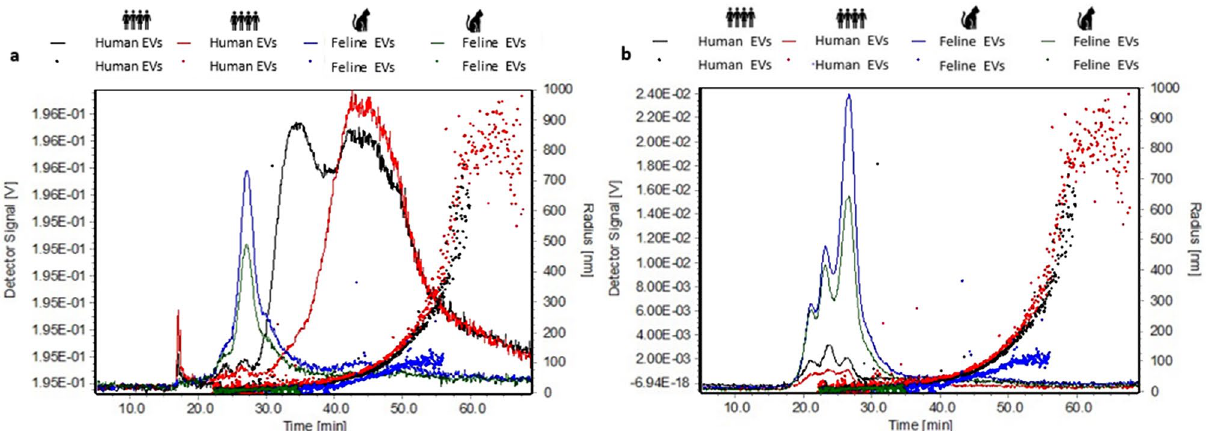
Figure 7. Asymmetrical flow field flow fractionation (AF4) of human and feline EVs. Asymmetrical field flow fractionation (AF4) was carried out on human and feline EVs. (a) Shows 90° light scatter signal (full lines, left hand scale) overlayed on the radius of gyration (dotted lines, right hand scale). Red and black lines represent the human EVs showing two distinct populations of EVs. One in the small EV range (< 200 nm) and another population of larger particles (> 200 nm). In contrast, the feline EVs indicated by blue and green lines show peaks that indicate only a small EV population only (< 200 nm). Radius of gyration (Rg) determined from light scattering signals was recorded from human and feline EV samples. These size differences show that the density of human EVs is different to the density of feline EVs, suggesting that their structure and shape are different. (b) Shows the radius of gyration (dotted lines, right hand scale) overlaid on UV detector signal (full lines, left hand scale) which shows the early eluting protein populations of the samples. The protein pattern of the human EVs (shown in black and red) was similar to feline EVs (blue and